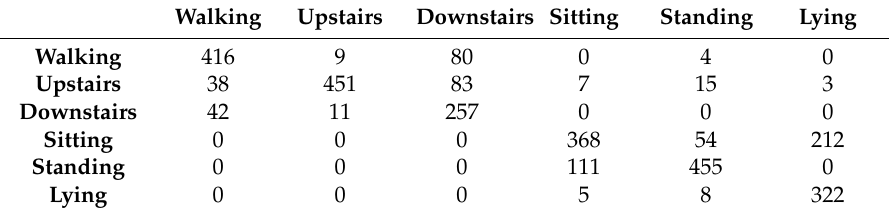
Table 7. Confusion matrix for no feature selection of the non-hierarchical case.